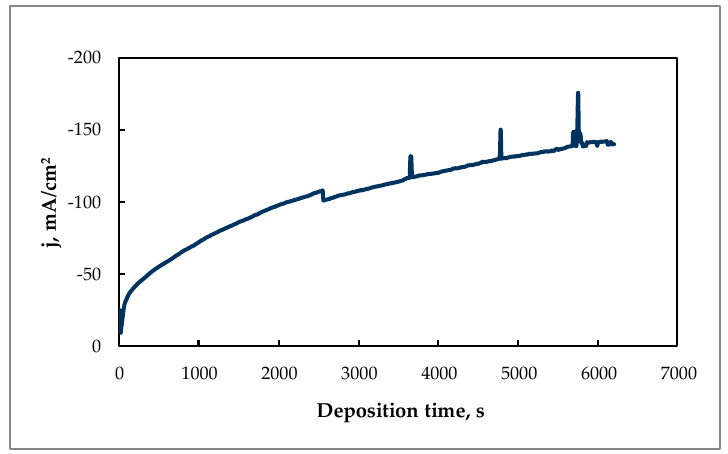
Figure 5. Chronoamperogram of Sn electrodeposition at E = − 0.85 V and 60 °C from the citrate solution. Content of the solution as indicated in Figure 4, substrate—Cu electrode.